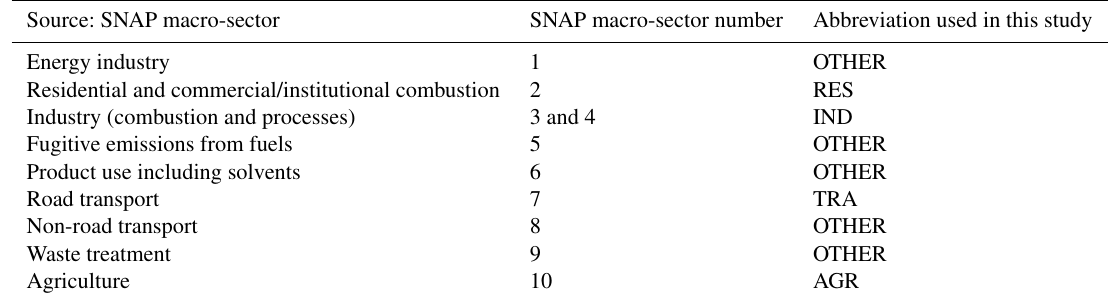
Table 1. Macro-sectors according to the EEA SNAP classification for emission inventories used to define air pollution sources in this study. Source: SNAP macro-sector SNAP macro-sector number Abbreviation used in this study Energy industry 1 OTHER Residential and commercial/institutional combustion 2 RES Industry (combustion and processes) 3 and 4 IND Fugitive emissions from fuels 5 OTHER Product use including solvents 6 OTHER Road transport TRA